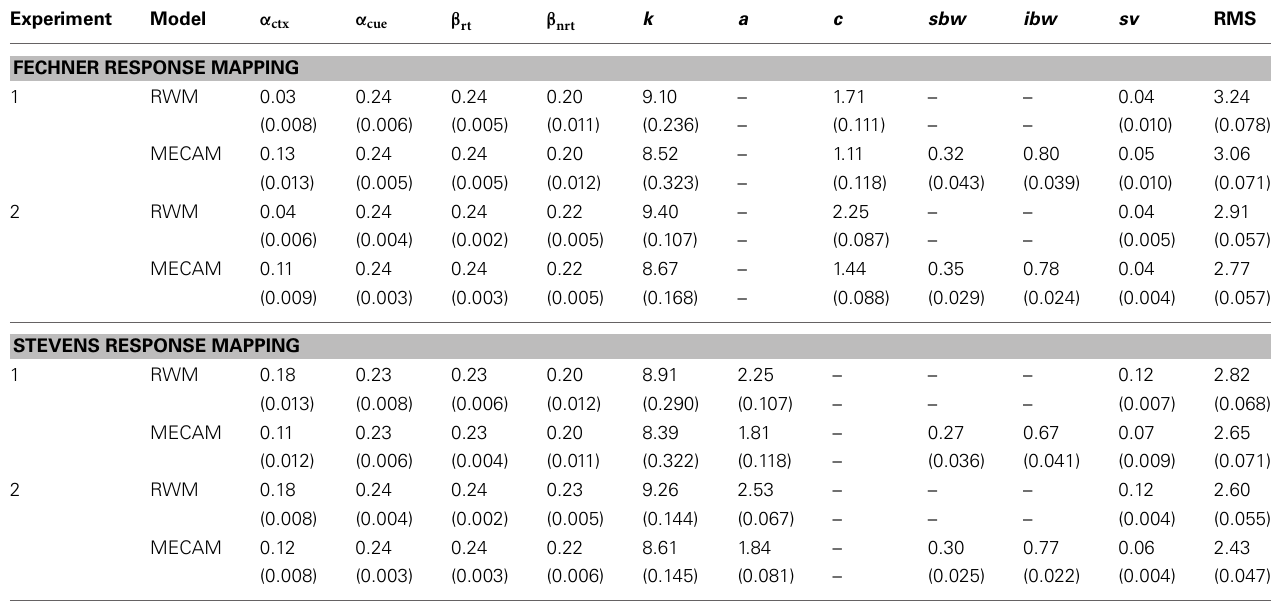
Table 1 | Parameters values obtained in Analyses 1 and 2 and model goodness of fit values